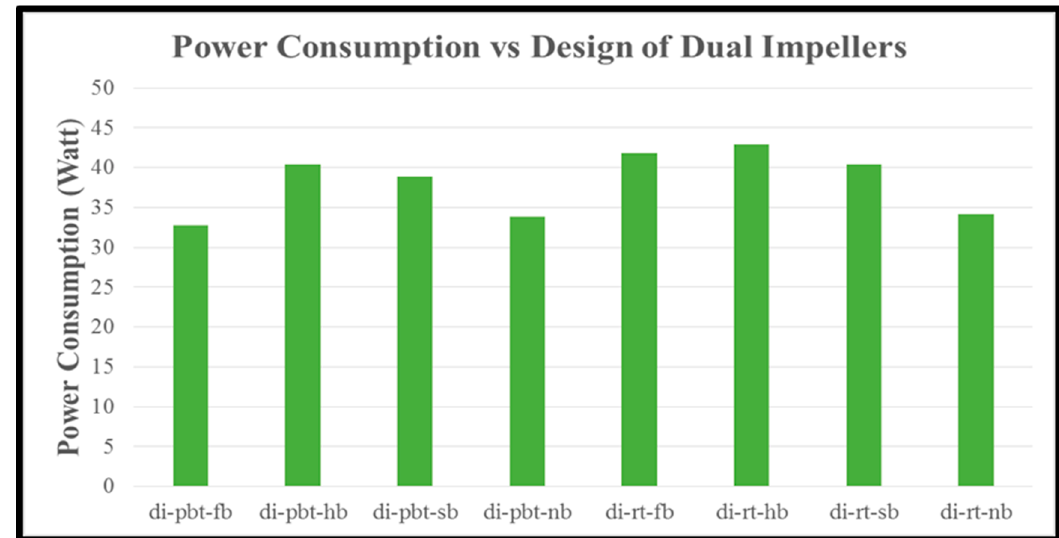
Figure 13. Power consumption of single impeller experiments.